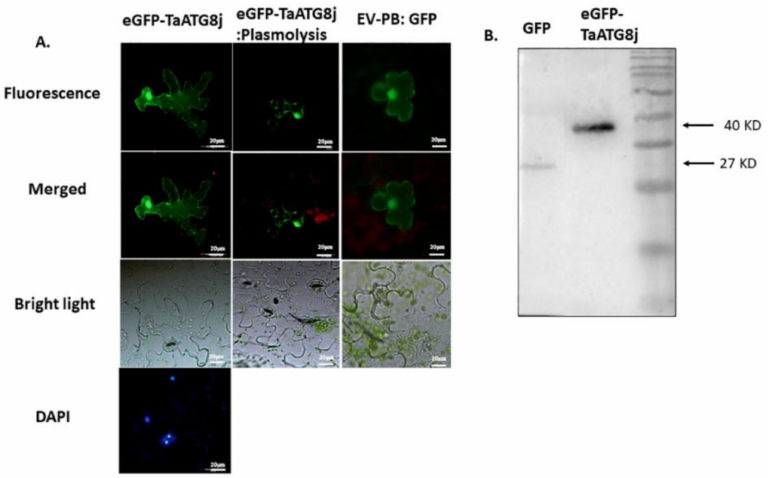
Figure 4. Subcellular localization and immunoblotting of the TaATG8j protein. ( A ) N. benthamiana leaf tissues were transformed with a plasmid carrying a fusion protein. The picture was obtained using a fluorescence microscope. The left four images indicate eGFP-TaATG8j, the middle three images indicate eGFP-TaATG8j: Plasmolysis, and the right three images indicate EV-PB: GFP (control); ( B ) Immunoblotting analysis of eGFP-TaATG8j (40 kDa) and EV-GFP (27 kDa). Bar: 20 µ